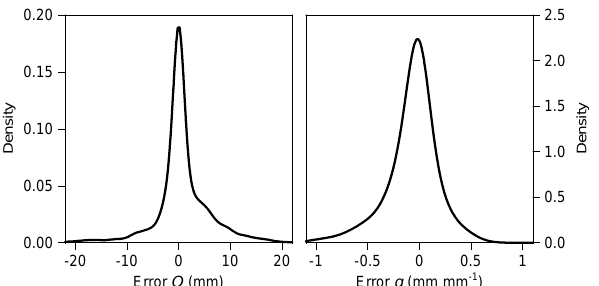
Fig. 1. Error distribution of accumulated runoff depth Q and instan- taneous runoff rate q for 14286 runoff measurements during 317 events.